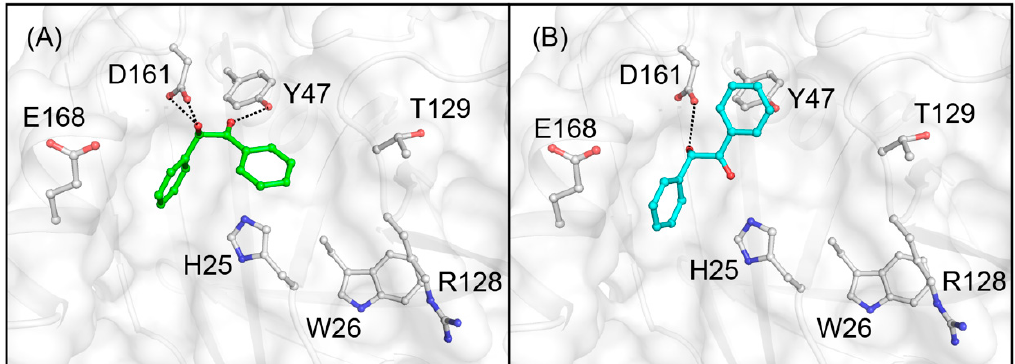
Figure 3. Simulated docking structures of cAGP focusing on the surrounding of bound ( A ) ( R )-benzoin and ( B ) ( S )-benzoin. The docked compounds were represented in either green or cyan for carbon atoms. Besides, nitrogen and oxygen atoms were colored in blue and red, respectively. The remarked amino acid residues were labeled and shown in gray for carbon atoms, and feasible interactions were depicted as dotted lines.